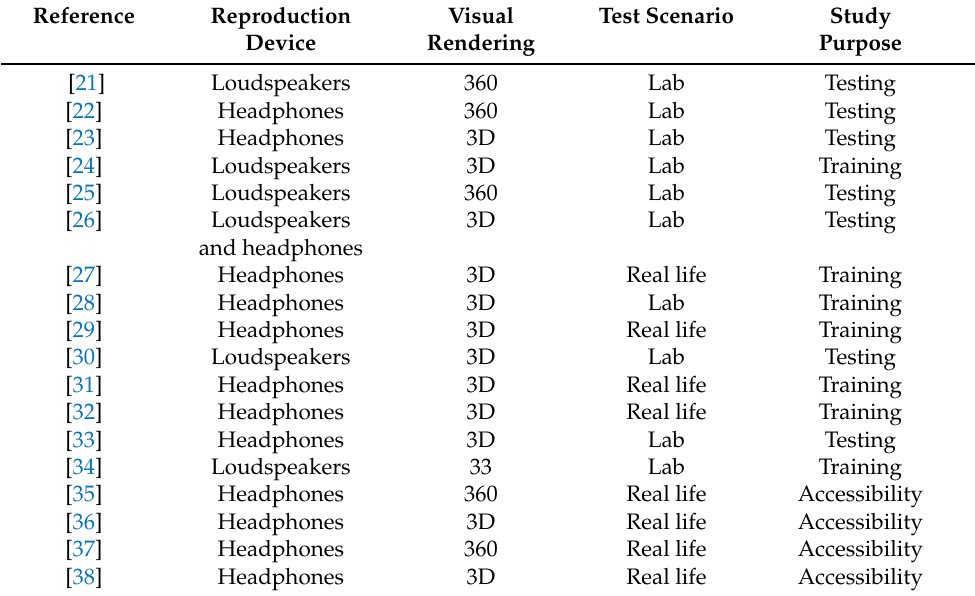
Table 1. Summary of the projects analyzed in this paper, including the sound delivery method (loudspeakers versus headphones), the visual content (3D versus 360 degrees video) if the application works only in laboratory settings or also in a real-life situation, and if it is used as a measuring or training